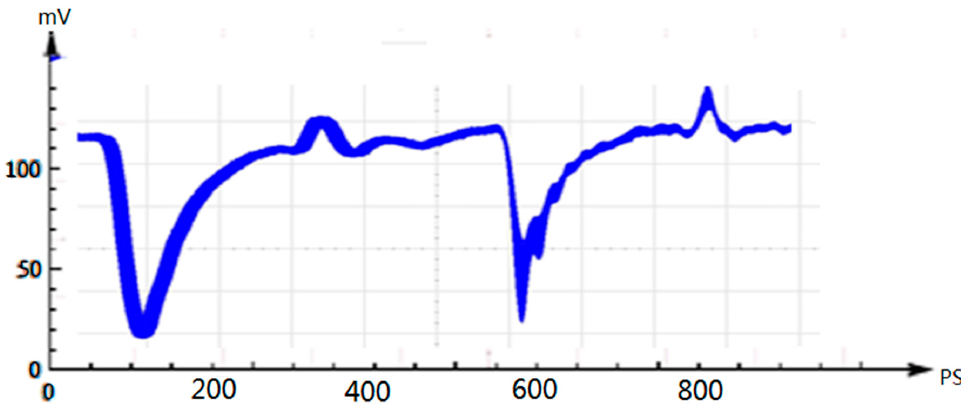
Figure 6. Persistently stored waveforms measured by the BCT1 and BCT2 under the condition with certain timing jitters.